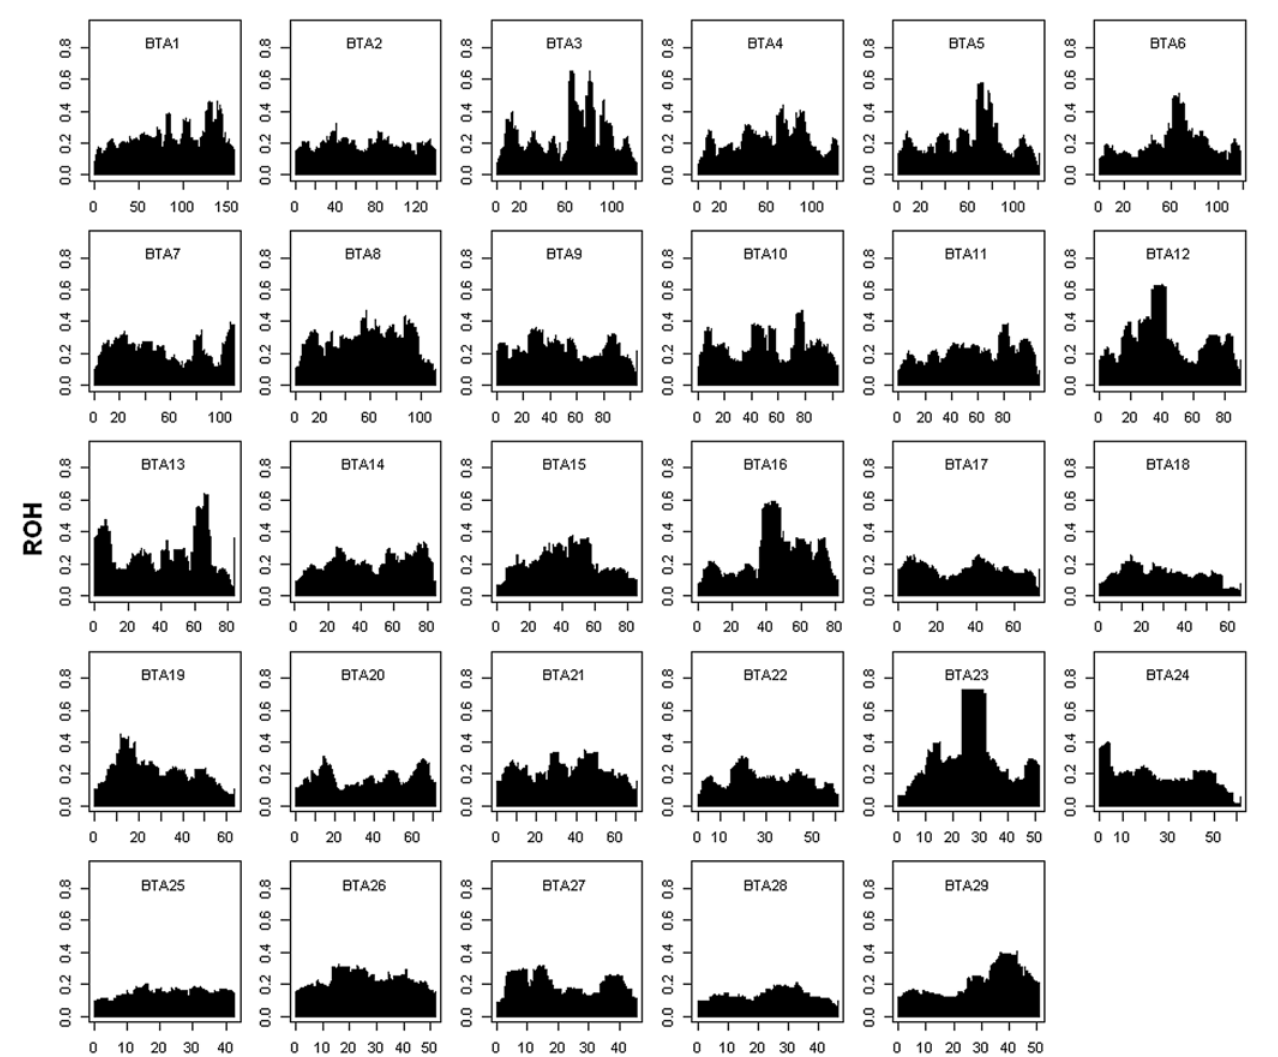
Fig 3. Runs of homozygosity (ROH) in each chromosome. The levels of ROH (y-axis) are plotted against the SNP genome coordinate on UMD 3.1